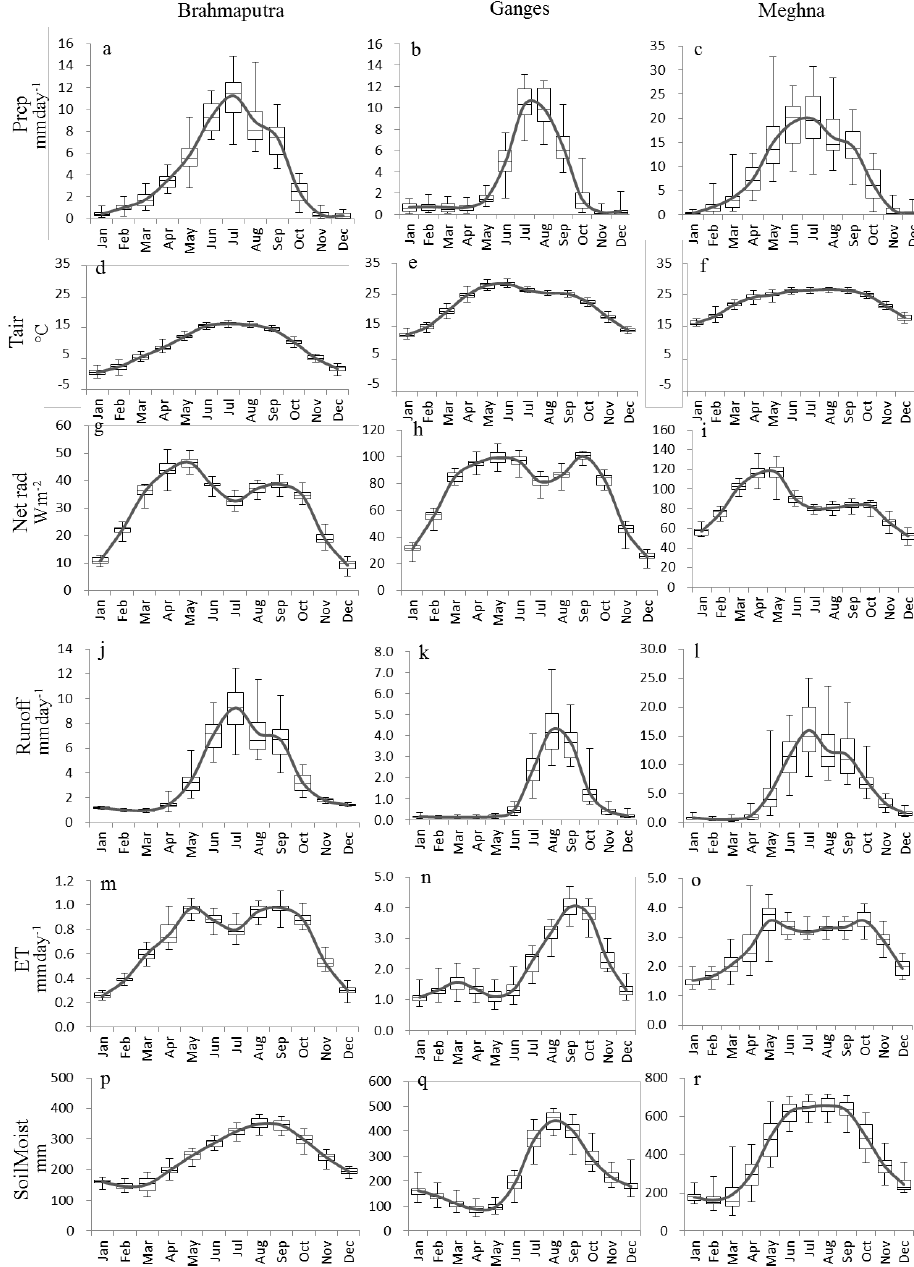
Figure 5. (a) – (r) Seasonal cycle of climatic and hydrologic quantities during 1980–2001. Box-and-whisker plots indicate minimum and maximum (whiskers), 25th and 75th percentiles (box ends), and median (black solid middle bar). Solid curve line represents the interannual average value. All abbreviated terms here refer to Table